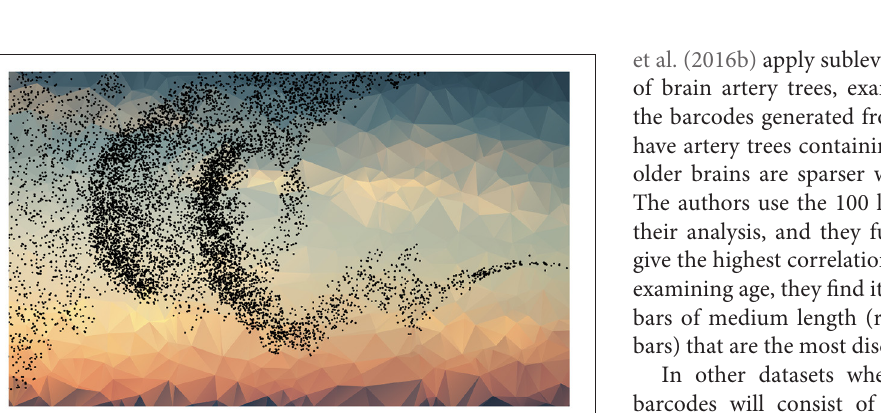
beautiful manifolds (global shapes), but nevertheless there is a wealth of information in the local geometry as measured by the short persistent homology bars. For example, Ulmer et al. (2019) show via time-varying persistent homology 3 that a control model for aphid motion, in which aphids move independently at random, does not fit experimental data as well as a model incorporating social interaction (distances to nearby neighbors) between the